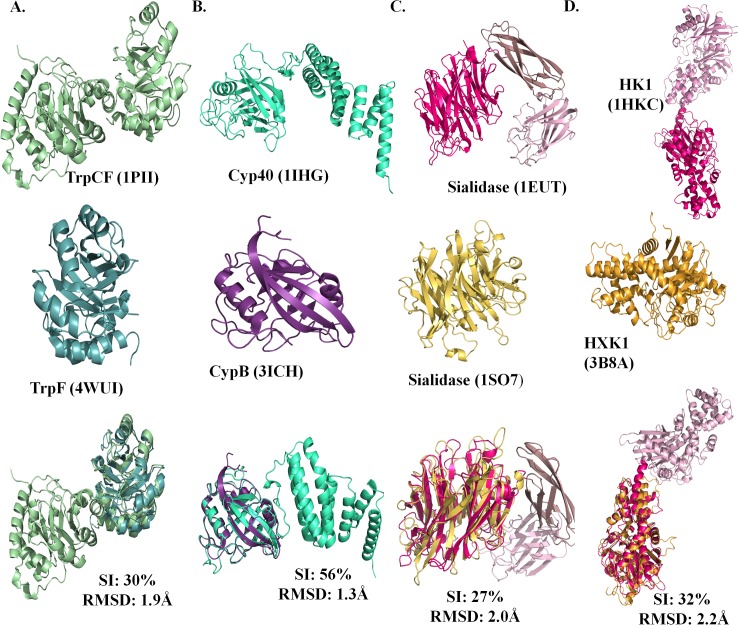
Homologous domain pairs.Four homologous domain pairs namely (A) phosphoribosylanthranilate isomerase from E. coli and Jonesia denitrificans, (B) cyclophilin from Bos taurus and Homo sapiens, (C) sialidase from Micromonospora viridifaciens and Homo sapiens and, (D) hexokinase-1 from Homo sapiens and Saccharomyces cerevisiae. The top panel shows the multi-domain protein, the centre panel shows the single-domain protein and the last panel shows the superposition of homologous domains, with sequence identity (SI) and RMSD values.